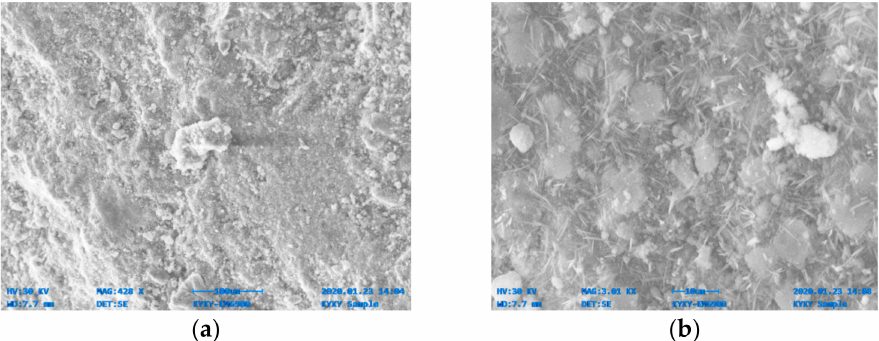
Figure 19. SEM image of OPC-0F mix specimen; ( a ) magnification 428 × ; and ( b ) magnification 3.01 × .